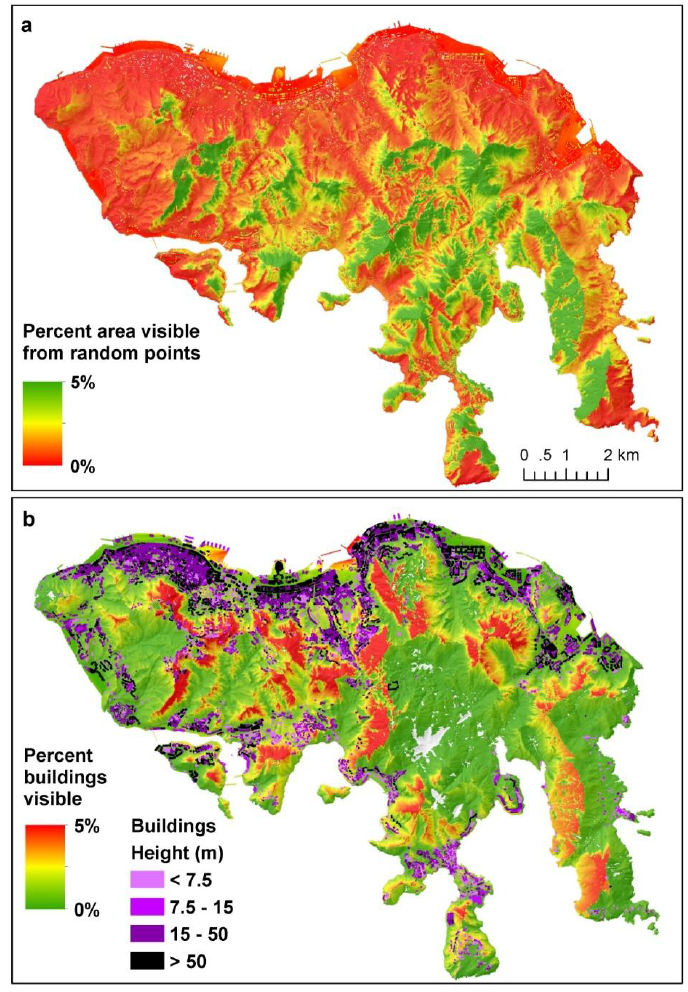
Figure 8. Visibility analysis taking into account building heights. In the upper map ( a ) visibility was calculated from a random sample of 44,000 points, and the map represents the percent area of Hong Kong Island visible from each pixel. In the lower map ( b ) visibility was calculated from the building roofs, and the map represents the percent of the buildings visible from each